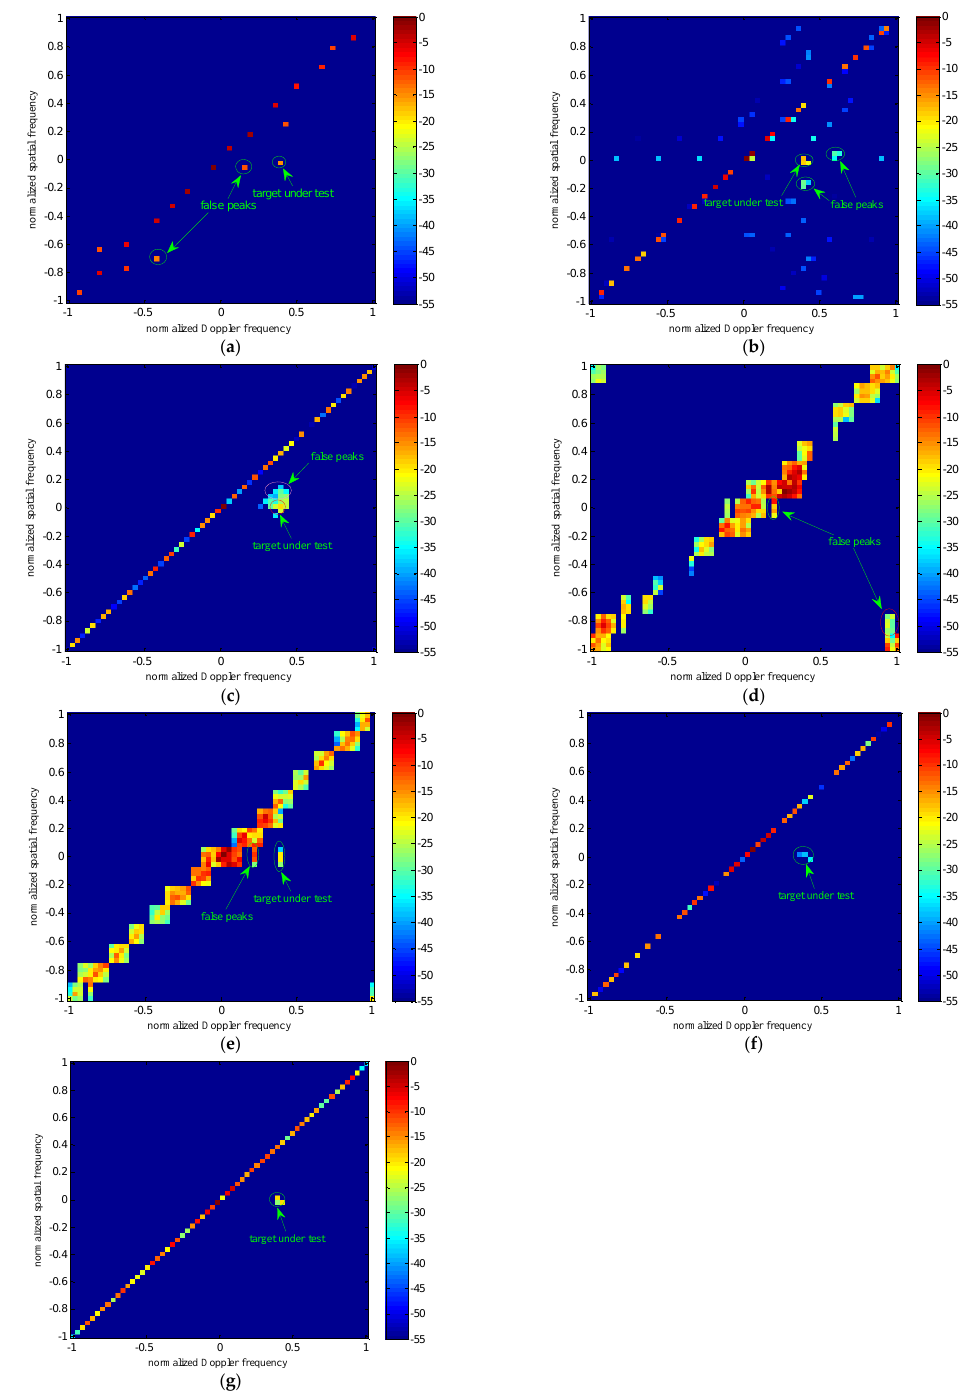
Figure 6. Sparse spectrum comparison of different algorithms: ( a ) sparse spectrum with UTSD- OMP; ( b ) sparse spectrum with UTSD-FOCUSS; ( c ) sparse spectrum with UTSD-SBL; ( d ) sparse spectrum with UTSD-BSBL-BO; ( e ) sparse spectrum with UTSD-BSBL-EM; ( f ) sparse spectrum with UTSD-TSBL; ( g ) sparse spectrum with